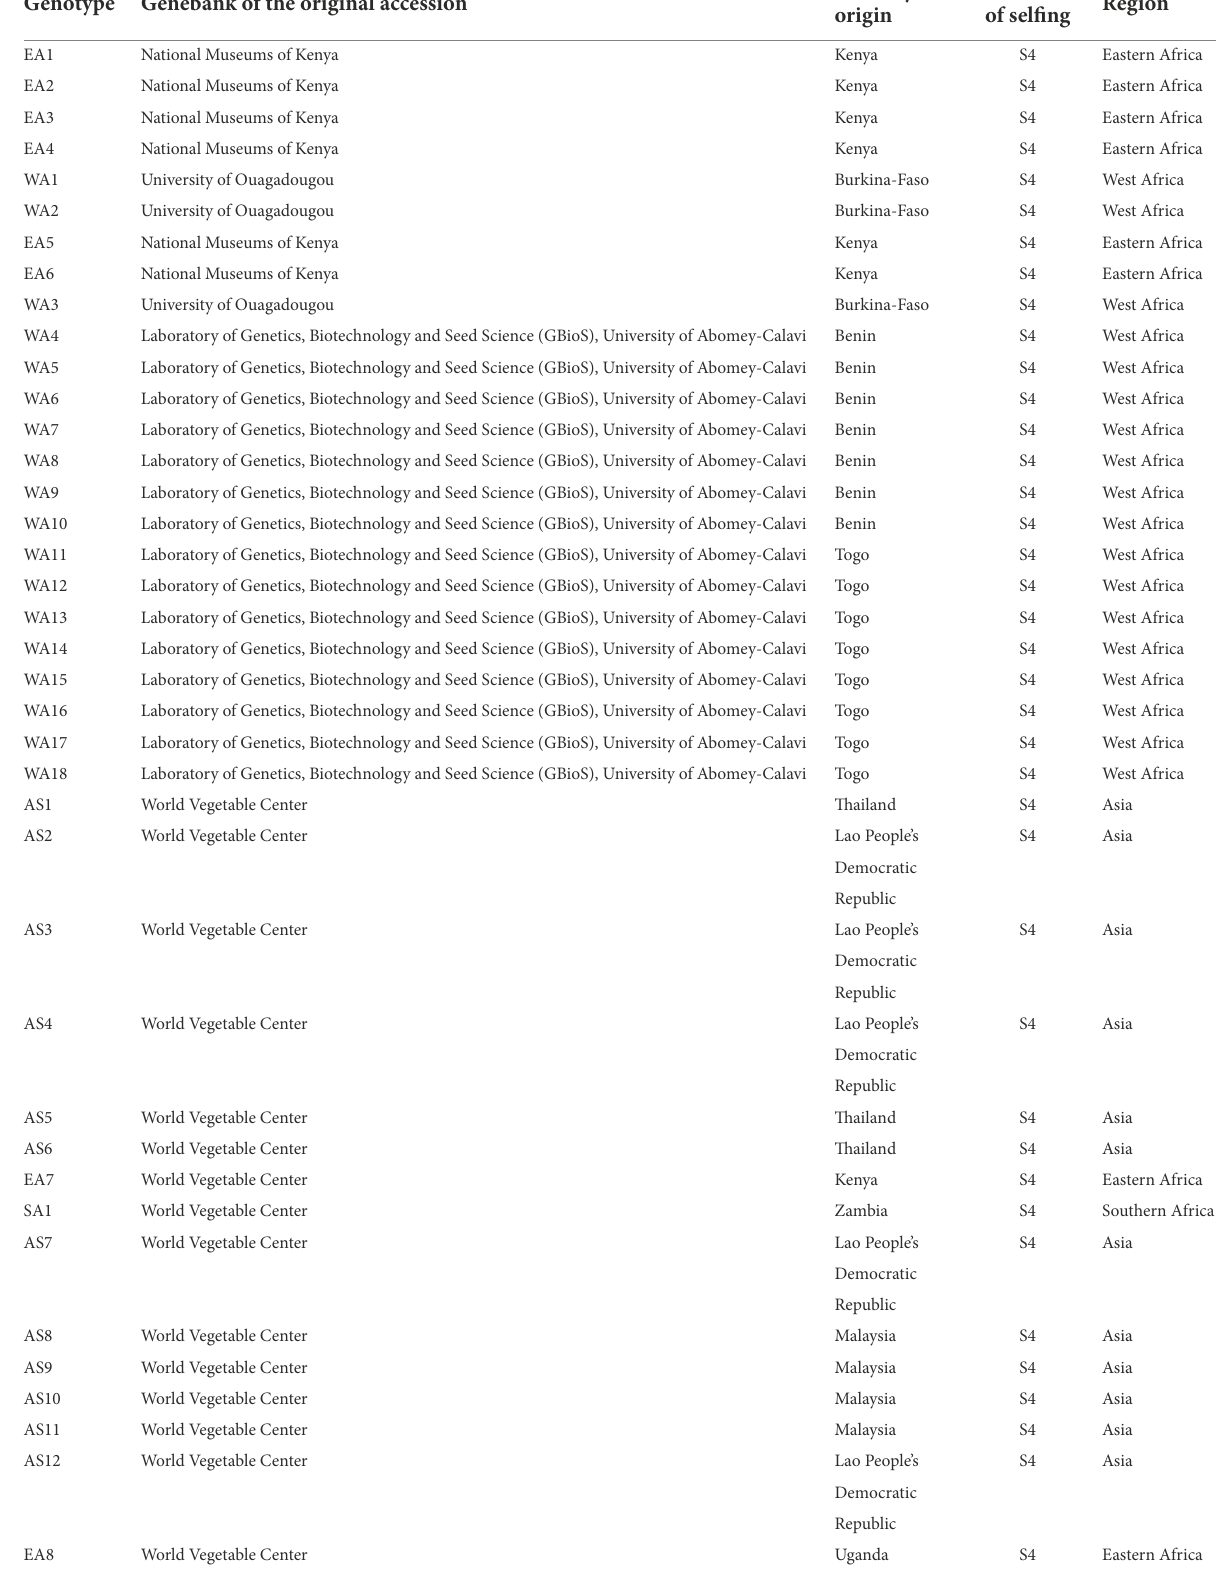
TABLE 1 List of advanced lines of Gynandropsis gynandra used in this study and their origin. Genotype Genebank of the original